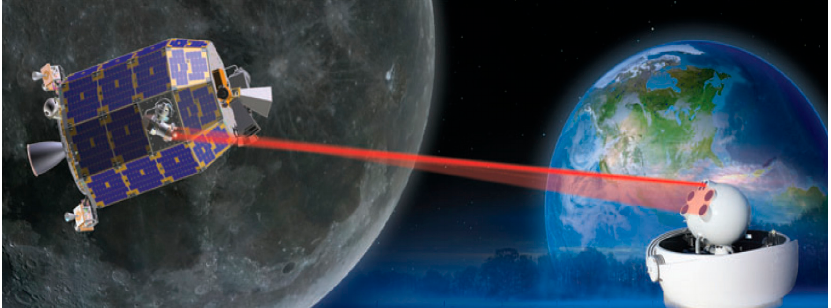
Figure 2. NASA’s First Space Laser Communication System Demonstration